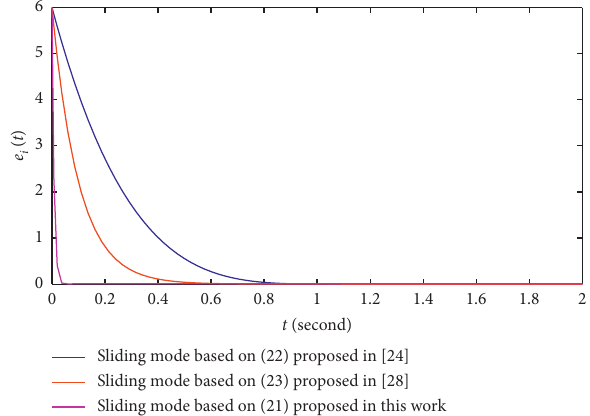
Figure 6: Comparison of the three sliding modes mentioned in this work with e i ( 0 ) �